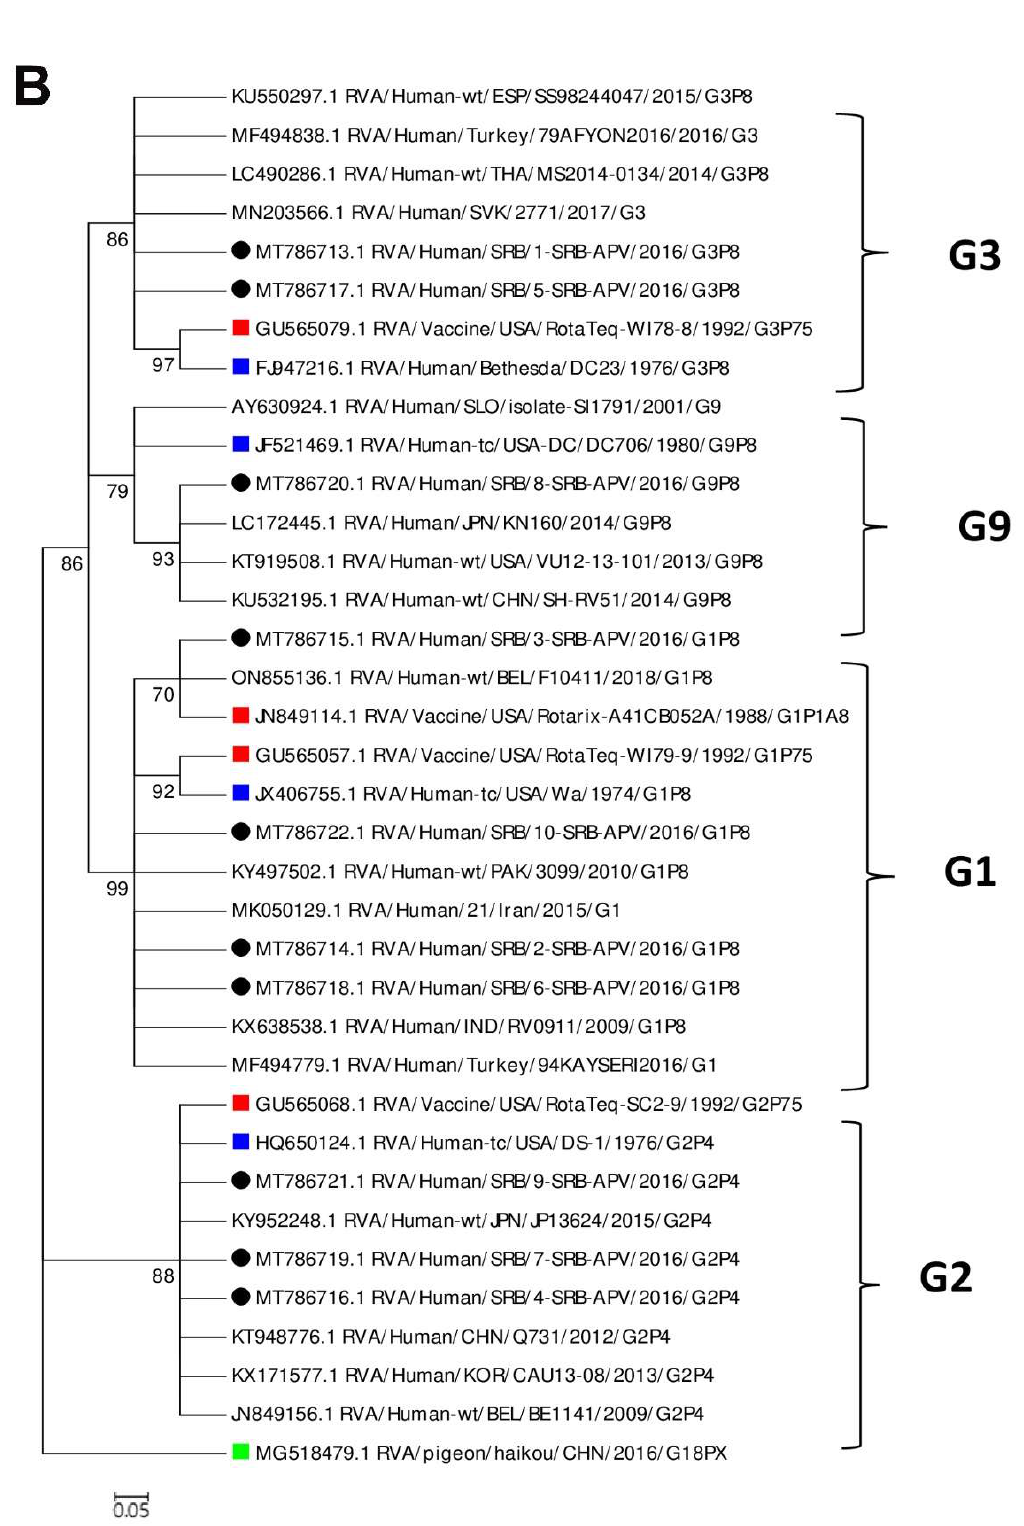
Figure 4. Phylogenetic relatedness of the rotavirus group A species based on VP4 gene ( A ), and VP7 gene ( B ). Phylogenies were reconstructed by the maximum likelihood method. The scale indicates nucleotide substitutions per position. Percentage bootstrap values above 70% are shown at branch nodes. Partial and complete sequences from other parts of the world and Rotarix™ and RotaTeq™ vaccine strains were included in the analysis. Key: The study sequences are indicated in black; vaccine strains in red; reference strains in blue; outgroups in green.